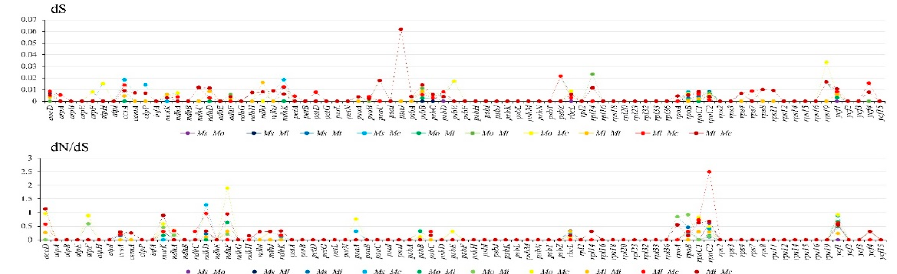
Figure 6. The synonymous (dS) and nonsynonymous substitutions (dN)/dS ratio values of 79 protein- coding genes from five Magnoliaceae chloroplast genomes (Ms: Michelia shiluensis ; Mo: Michelia odora ; Ml: Magnolia laevifolia ; Mi: Magnolia insignis ; Mc: Magnolia cathcartii ).